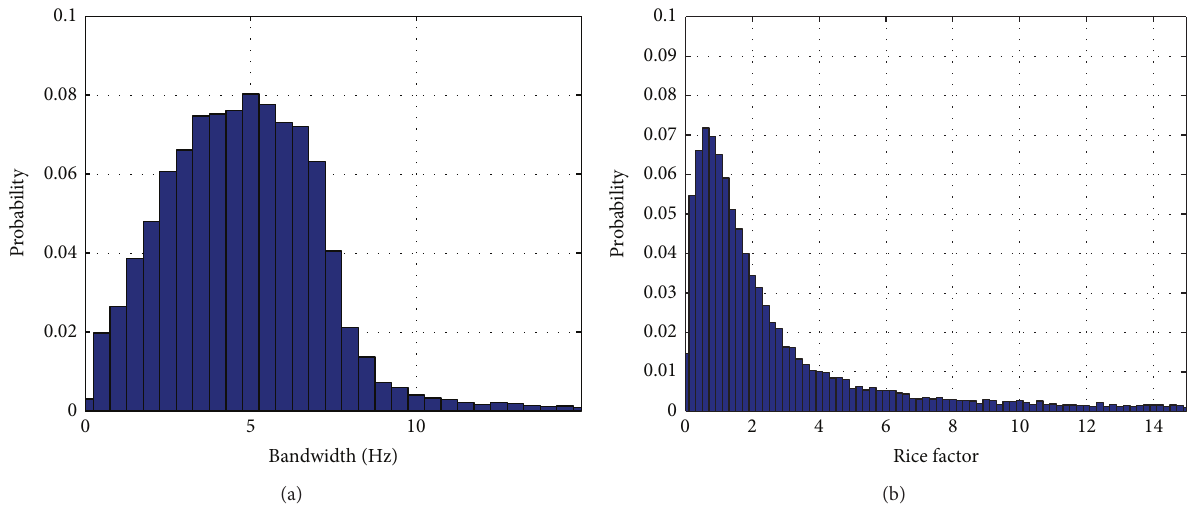
Figure 9: Discrete probability density functions of the double sided 3 dB echo bandwidth and of the echo signal Rice factor in the urban city center environment.